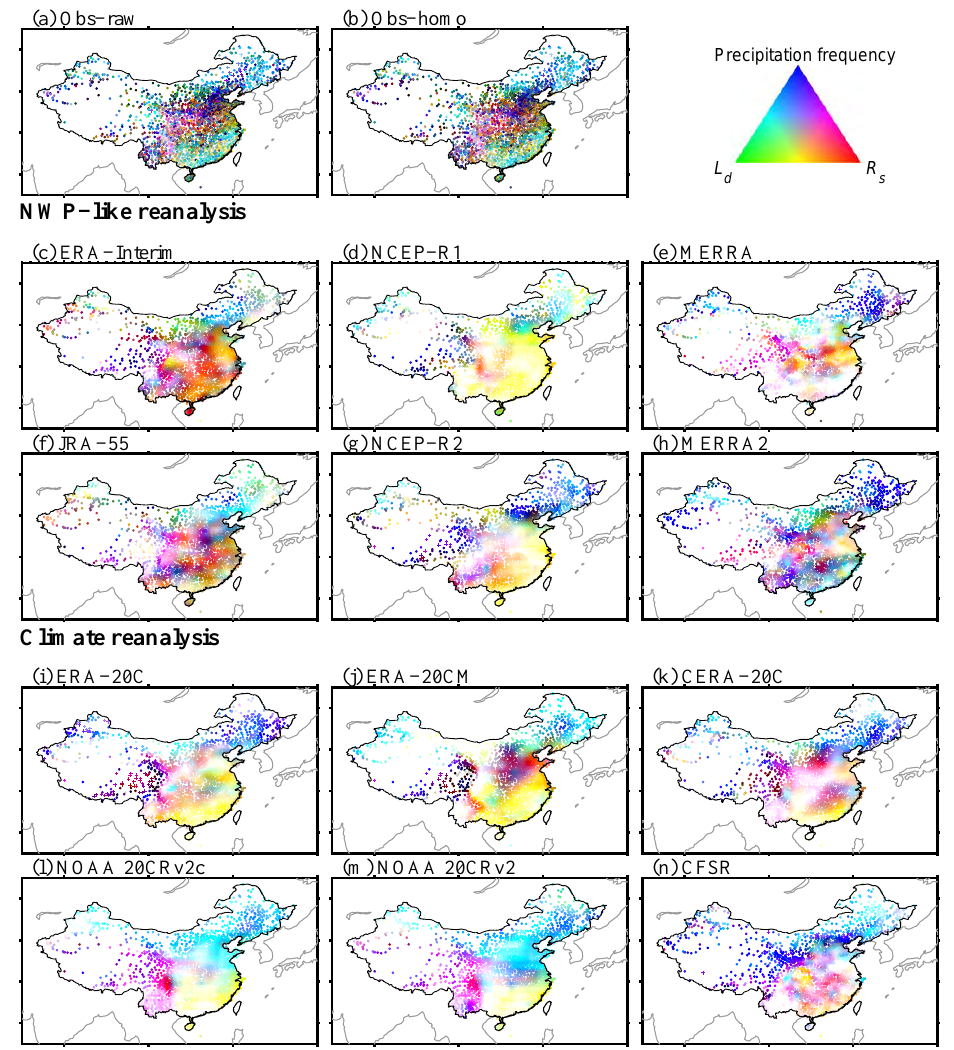
Figure 4. Composite map of partial correlation coefficients of the detrended surface air temperature ( T a , unit: ◦ C) against surface incident solar radiation ( R s ), precipitation frequency (PF) and surface downward longwave radiation ( L d ) during the period of 1979–2010 from observations and the 12 reanalysis products. The marker “ + ” denotes the negative partial correlations of T a with R s over the Tibetan Plateau in NCEP-R2, ERA-20C and